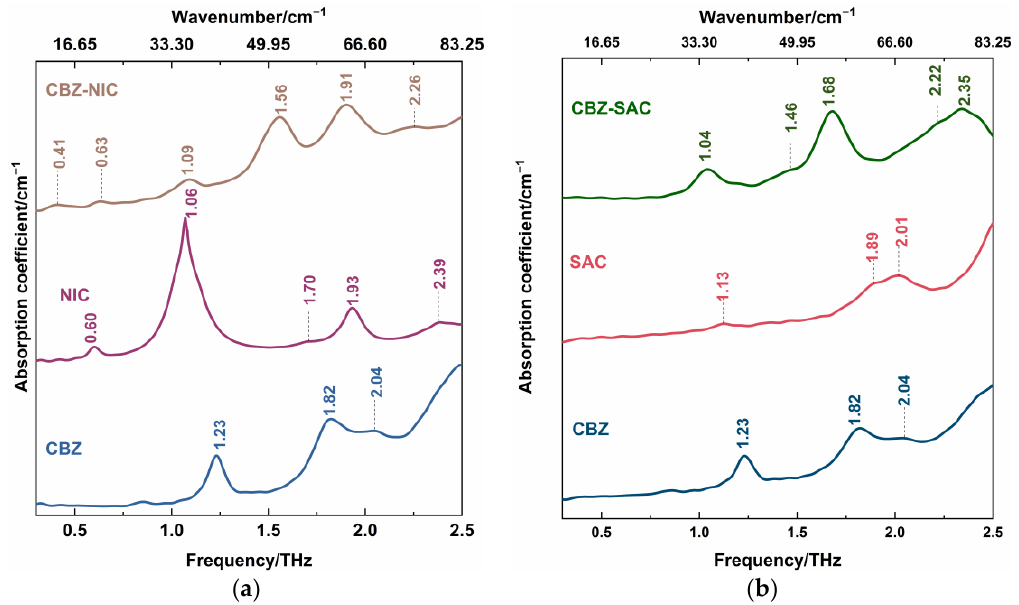
Figure 4. THz spectra of ( a ) CBZ-NIC and ( b ) CBZ-SAC co-crystals with their individual constitu-